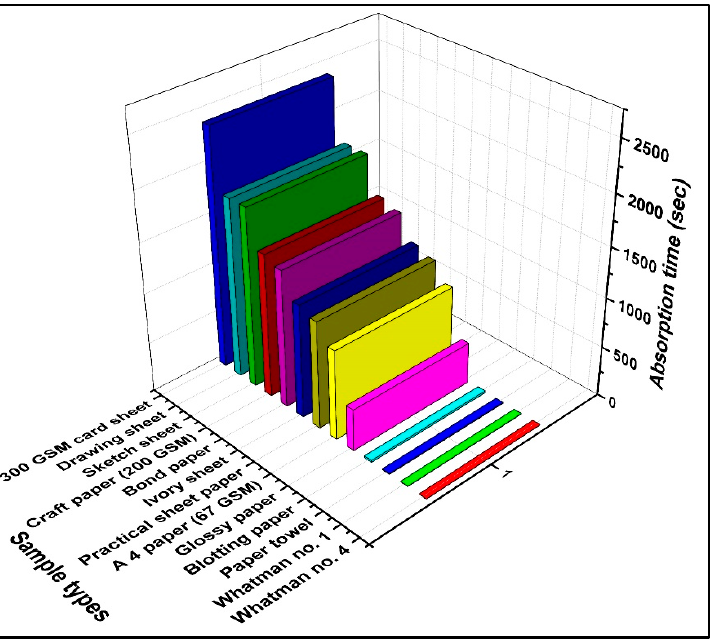
Figure 3. Graph representing the absorption times for a fixed volume of dye solution with Sdifferent papers .